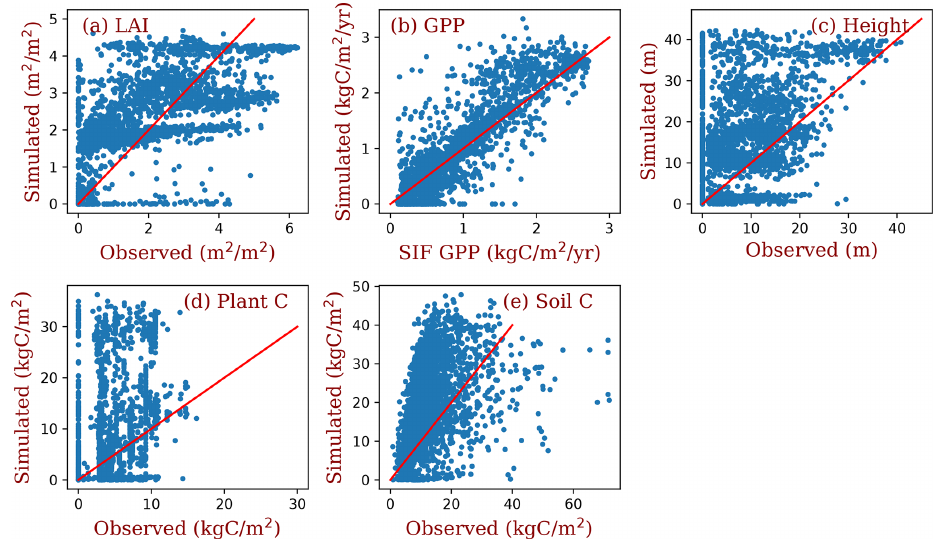
Figure 8. Grid comparison of full demographic BiomeE simulations with observations estimates. The red line in each panel is the 1 : 1 line. The data used in this figure are the same as those in Fig.